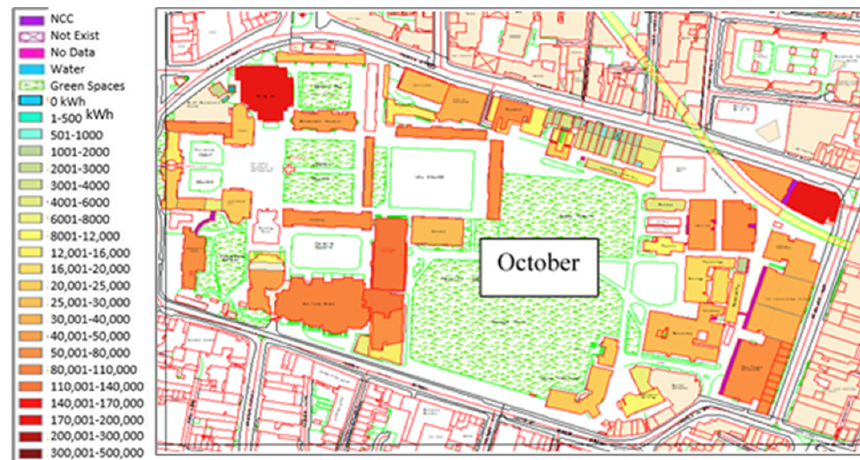
Figure 11. Heat map of October.